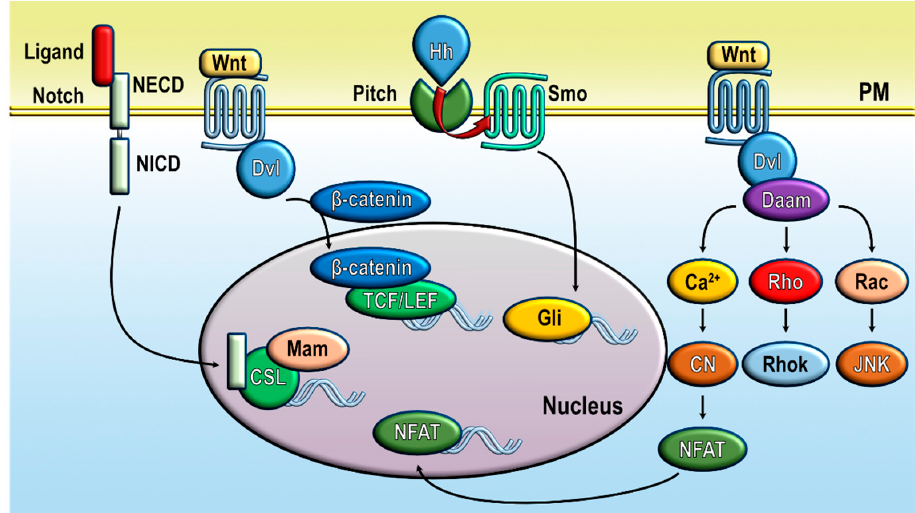
Figure 1. Notch, Wnt, and Hedgehog pathways in CSC. NECD, Notch extracellular domain; NICD, Notch intracellular domain; Mam, Mastermind; Dvl, Dishevelled; TCF/LEF, T-cell factor/lymphoid enhancer factor; Hh, hedgehog; Smo, Smoothened; Gli, glioma-associated oncogene; Daam, Dishev- elled associated activator of morphogenesis; RhoK, Rho-kinase; CN, calcineurin; NFAT, nuclear factor of activated T-cells.